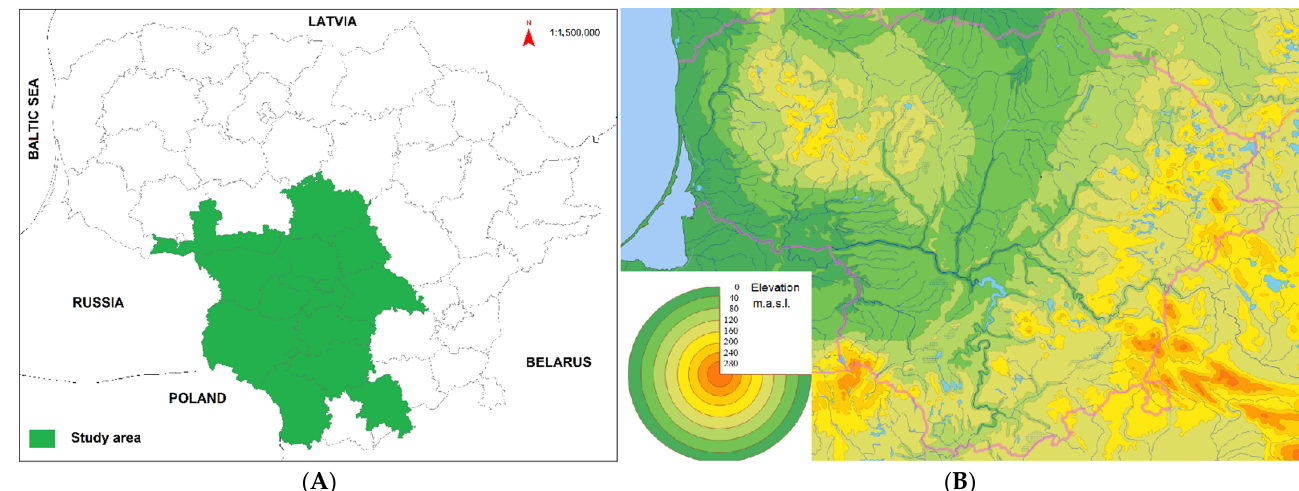
Figure 1. The map ( A ) illustrates the specific study area, covering the regional divisions of State Forest Enterprise in Lithuania where the study plots were selected in 2016, and the map ( B ) is a topographic map of the country.